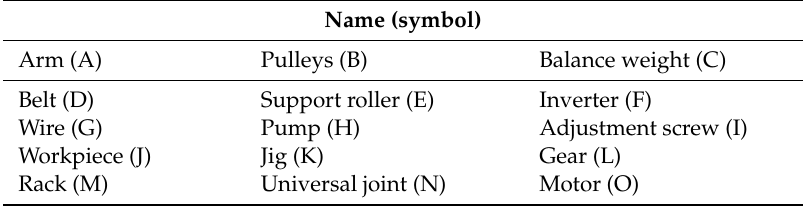
Figure 1. Photo of a system with a single wire-saw [21]. Table 1. All element names and symbols of the single wire-sawing system.